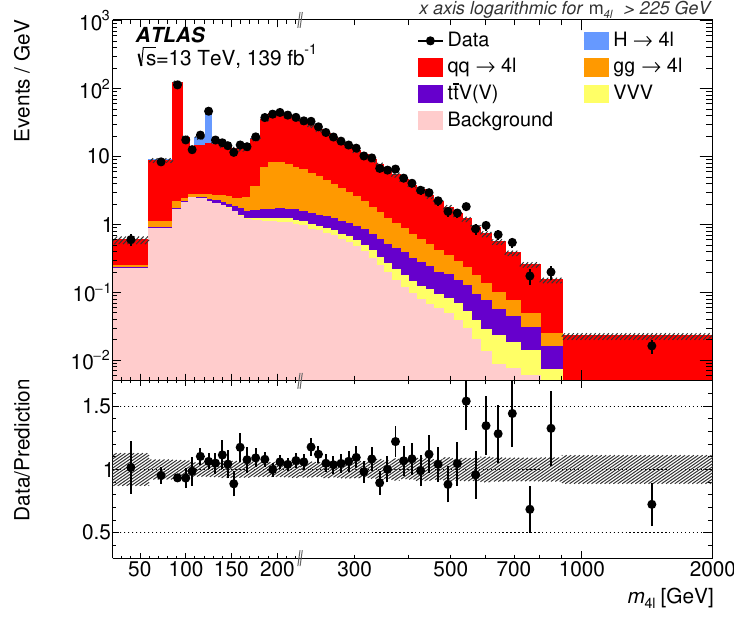
Figure 3 . Observed reconstruction-level m 4 ‘ distribution compared with the SM prediction, using Sherpa for the q ¯ q → 4 ‘ simulation. The statistical uncertainty of the data is displayed as error bars and systematic uncertainties in the prediction are shown as a grey hashed band. The ratio of the data to the prediction is shown in the lower panel. The x -axis is on a linear scale until m 4 ‘ = 225 GeV, where it switches to a logarithmic scale, as indicated by the double dashes on the axis. There is one additional data event reconstructed with m = 2 . 14 TeV, while 0.4 events are 4 ‘ expected from simulation for m 2 4 ‘ >